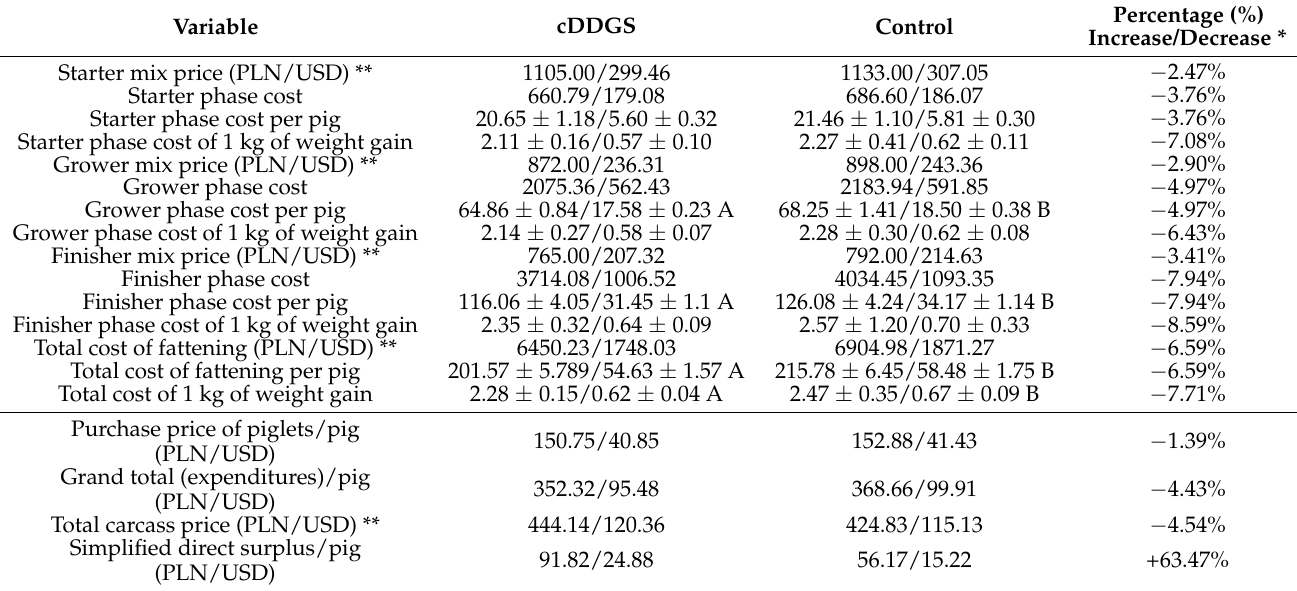
Table 6. The cost of nutrition and profitability of pig fattening.